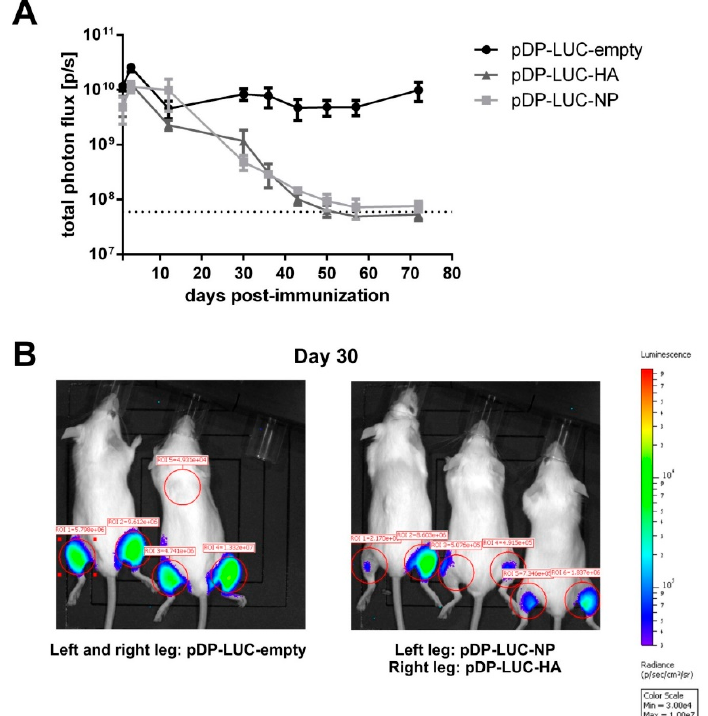
Figure 1. DNA electroporation of influenza antigens: in vivo antigen expression and immunogenicity. ( A ) Long-term antigen expression after DNA electroporation. BALB/c mice ( n = 2–3) were